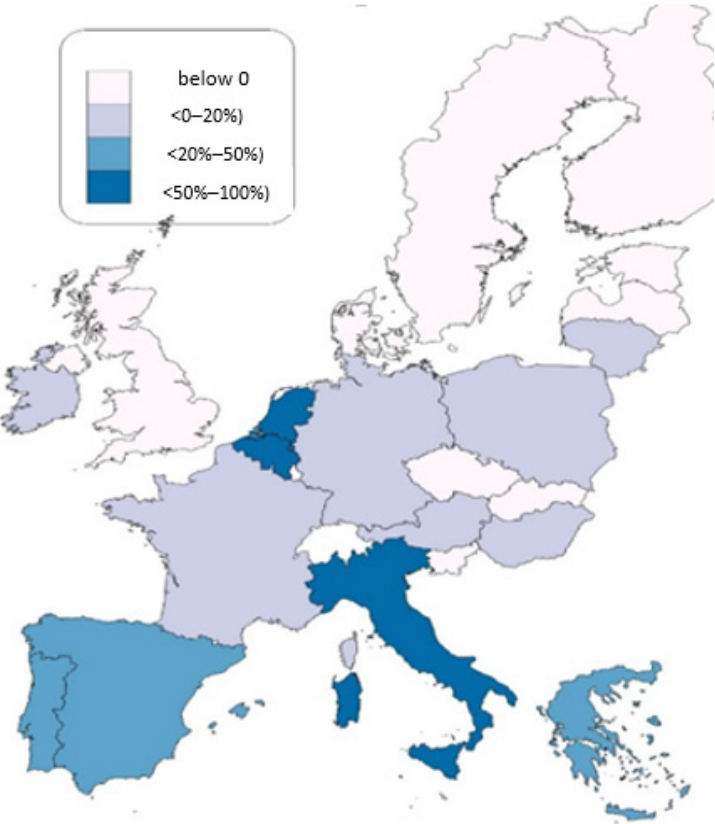
Figure 1. Ratio of family farm income without family work unit (FWU) subsidies to non-agricul-